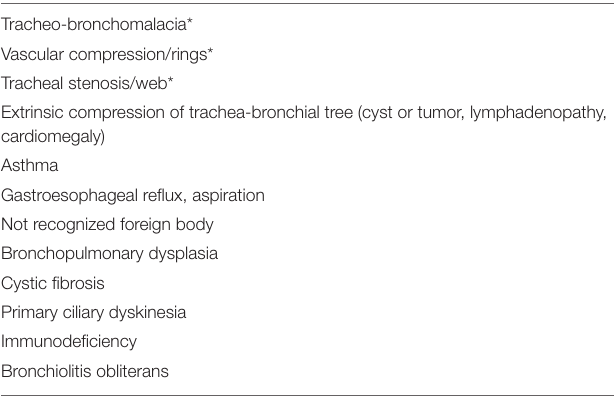
FIGURE 1 | Flow chart on differential diagnosis of wheezing in children. The main causes of acute wheezing are highlighted in red, whereas the conditions underlying a chronic wheezing are colored in blue. TABLE 1 | Causes of recurrent/chronic wheezing in